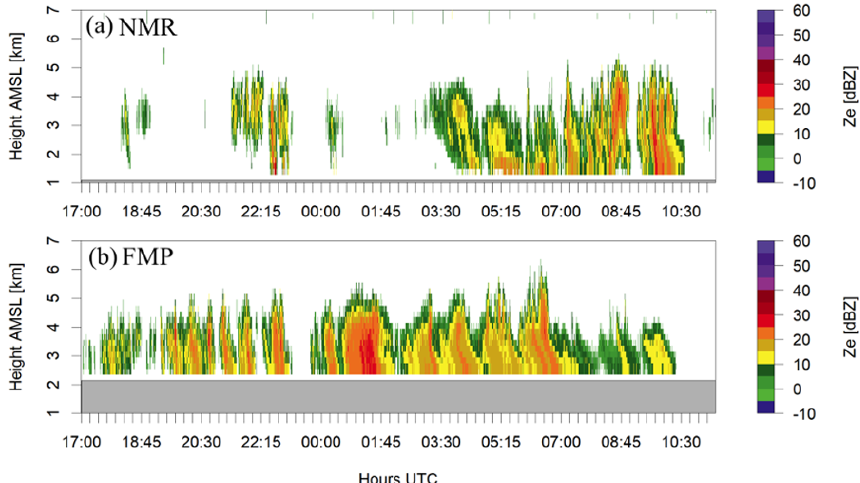
Figure 5. MRR-2 vertical profile of reflectivity (Ze) from 17:00UTC 4 May–11:30UTC 5 May for (a) NMR and (b) FMP. The grey shading is below ground level. Data from the MRR-2 have been processed using Maahn and Kollias (2012).